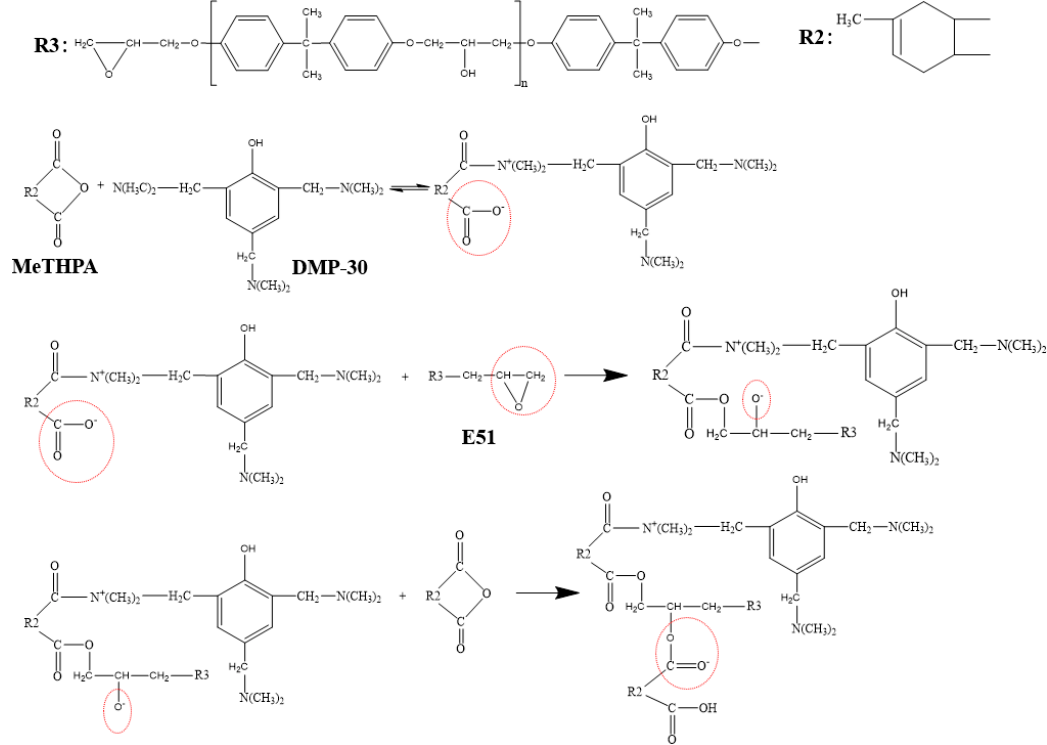
Figure 14. Schematic diagram of curing reaction of epoxy resin.